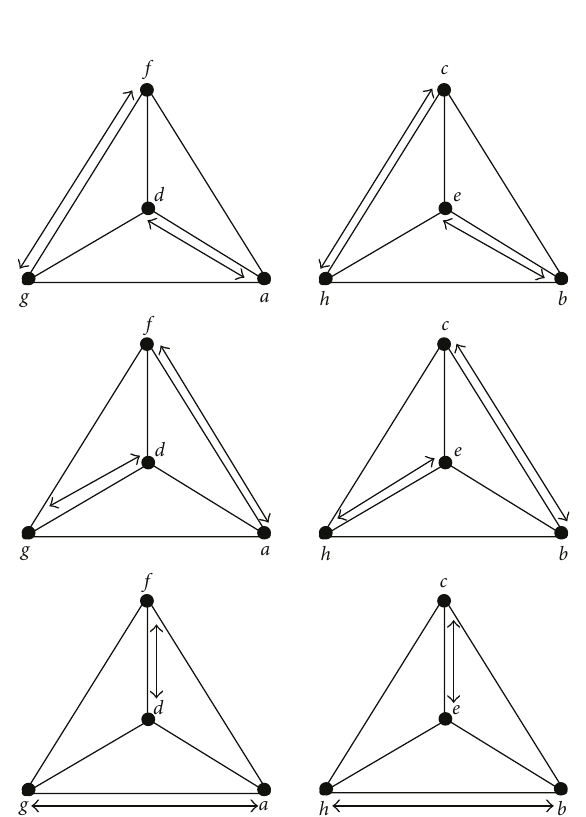
Figure 14: The two-party ECDH key agreement sequence in the internal